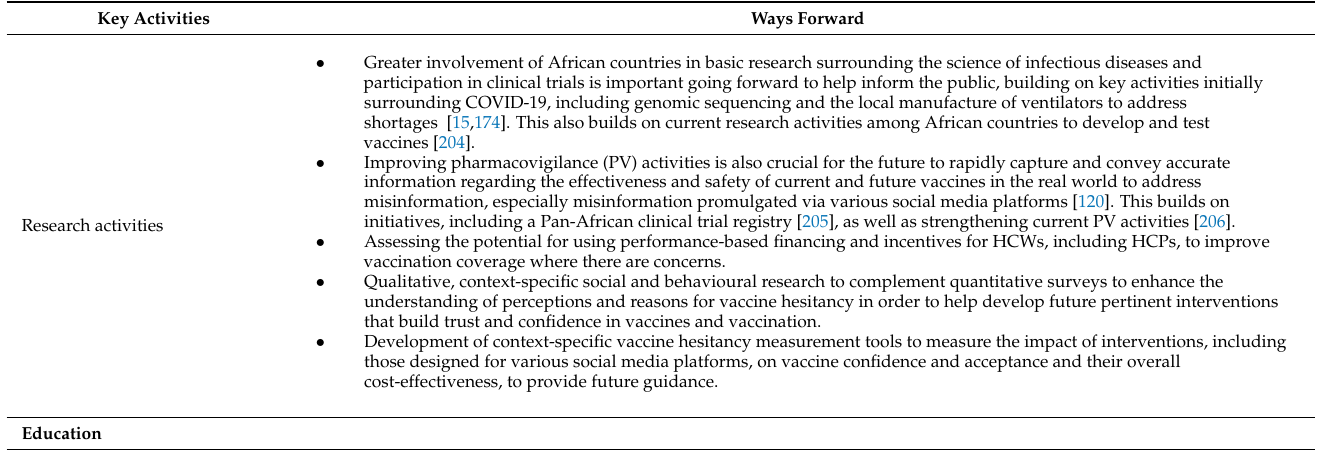
Table 5. Key activities to improve vaccination rates in current and future